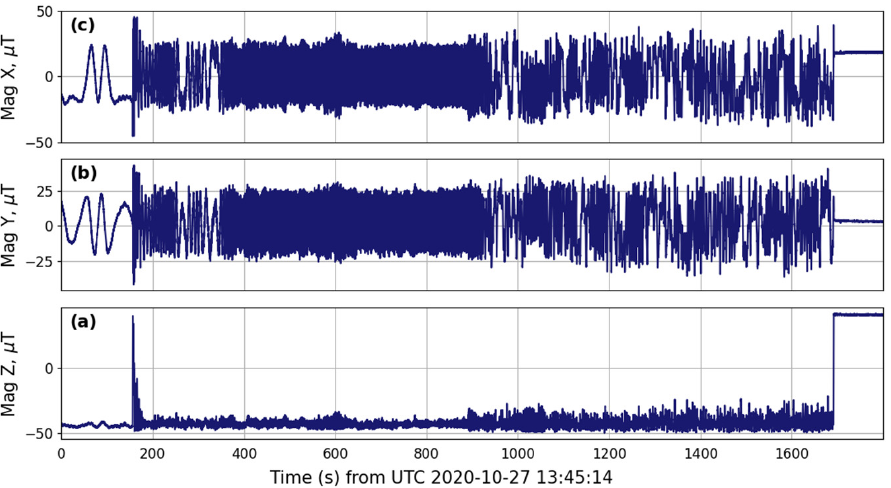
Figure 16. Magnetometer channel payload for ( a ) Z-direction component, ( b ) Y-direction component, and ( c ) X-direction component.